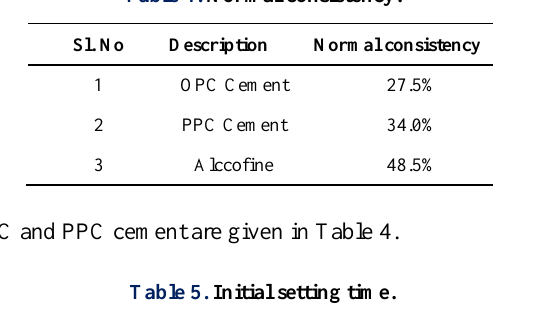
Table 4. Normal consistency.